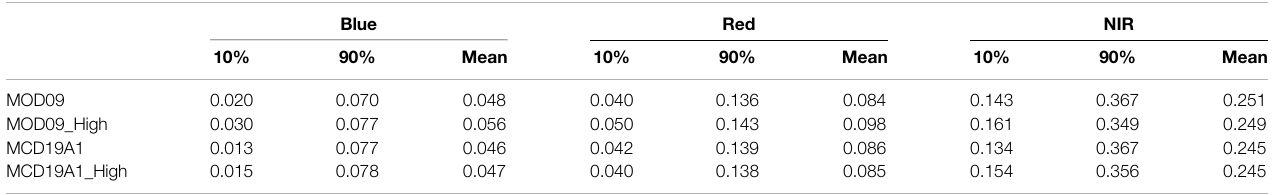
TABLE 2 | Comparison of the surface re fl ectance statistics (10th and 90th percentiles and the mean value) at low and high AOD for MOD09 and MCD19A1. For each product, the top line represents the high quality pixels, and the bottom line represents pixels at moderate-high AOD (MAIAC AOD 0.47 (cid:1) 0.6 – 1.5) for tile H27V05. Blue Red NIR 10%